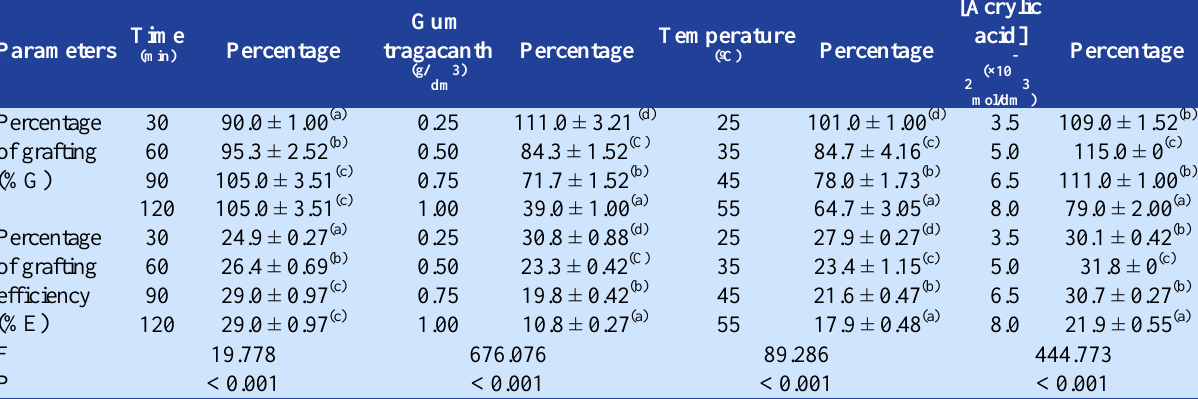
Table 1. Descriptive statistic of reaction conditions on grafting parameters Time Parameters